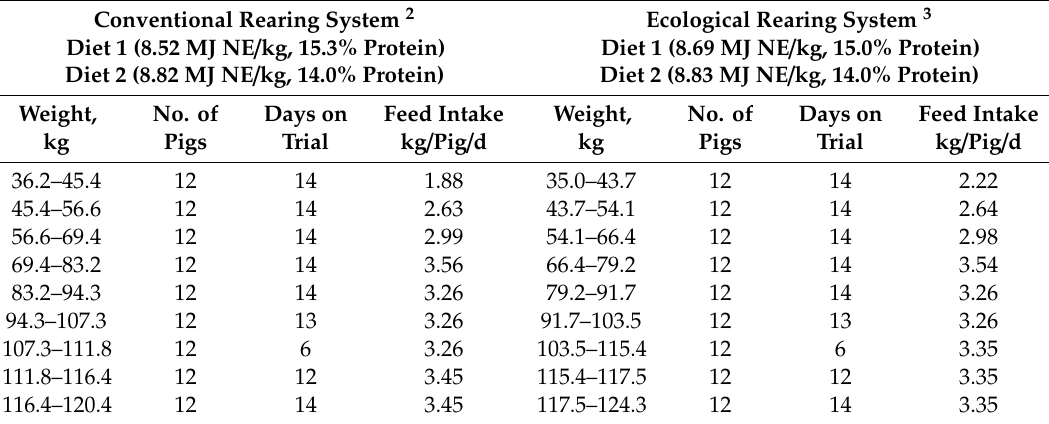
Table A8. Data on Krškopolje pig breed used for modelling (Project TREASURE) 1 . Conventional Rearing System